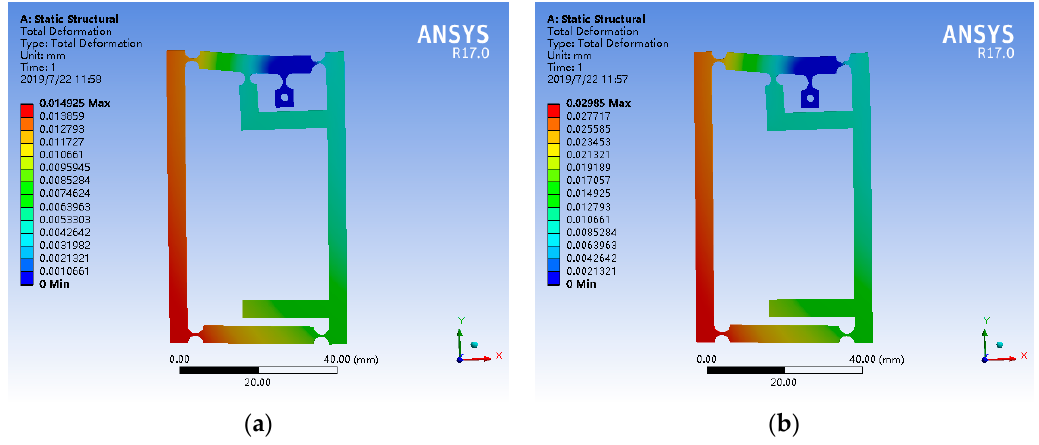
Figure 6. Simulation of amplifier mechanism. ( a ) Input displacement 5 μ m. ( b ) Input displacement 10 μ m.